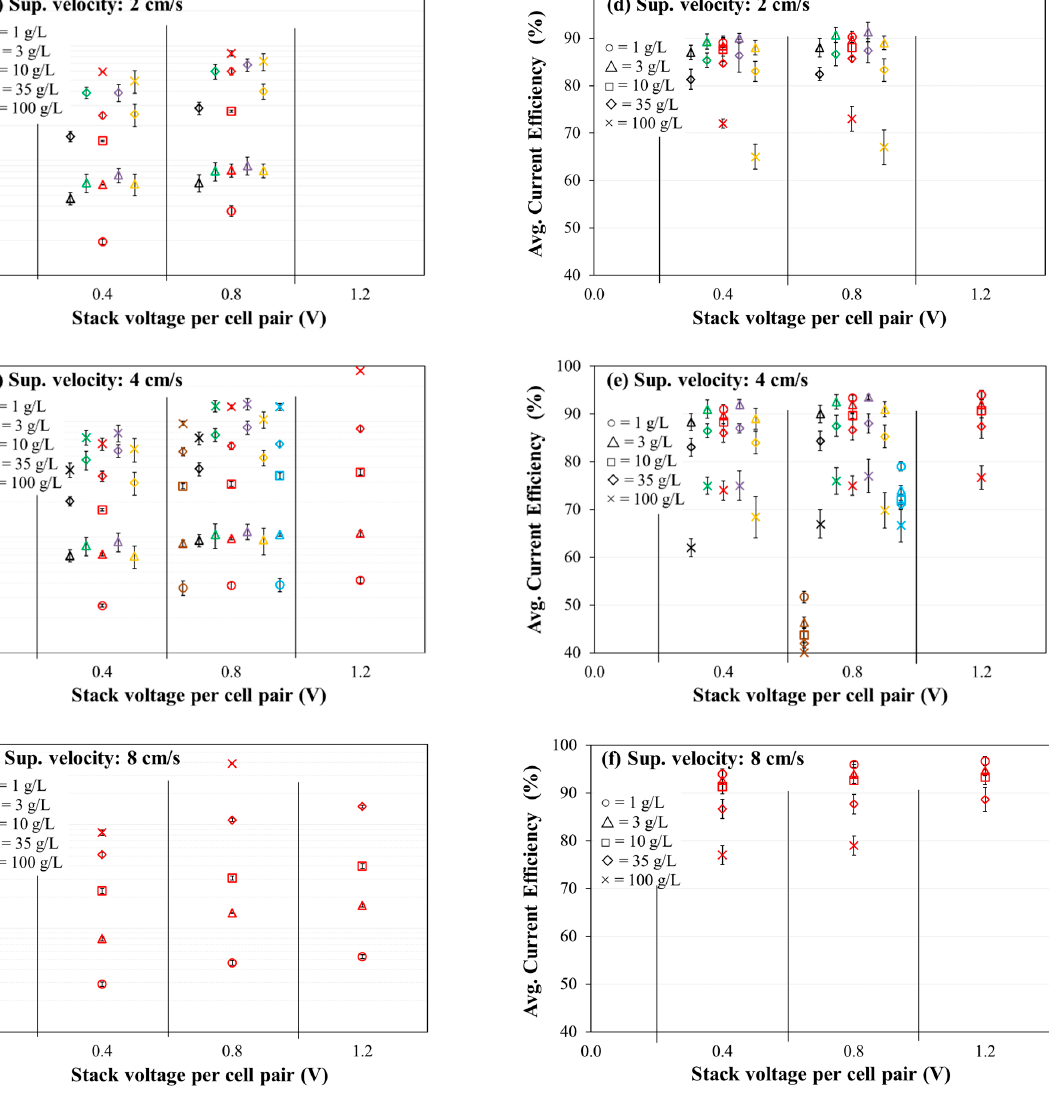
Figure 4. Average current density ( a – c ) and average charge efficiency ( d – f ) for 60 min of experiment against applied stack voltage per cell pair of the membrane. Experimental conditions: Five cell-pairs stack; 1–100 g/L initial concentration of NaCl feed (diluate and concentrate) solutions (500 mL each); 2, 4, and 8 cm/s superficial velocity of feed solution; 0.4, 0.8, and 1.2 V/cell-pair constant applied stack voltage; 0.1 M (14.2 g/L) Na 2 SO 4 electrode rinse solution; and 3 kPa transmembrane pressure. Representation of membranes, left to right: Brown: AMX/Polycarb, Black: Ralex CMH-PES/AMH-PES, Green: PCA PCSK/PCSA, Red: Neosepta AMX/CMX, Purple: Fujifilm Type 1 AEM/CEM, Orange: SUEZ AR204/CR67, Blue: AMX/SandiaCEM.